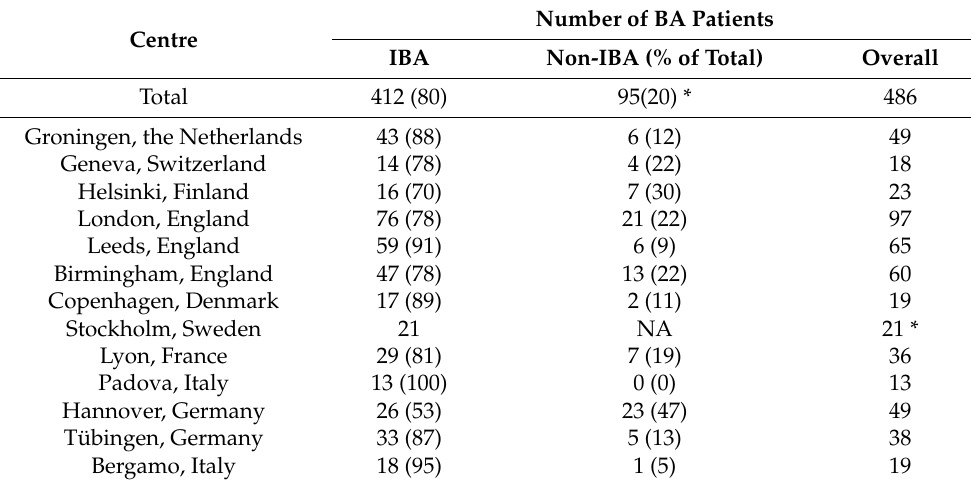
* Stockholm provided data on IBA patients only. The proportion of non-IBA patients was calculated without data from Stockholm in this